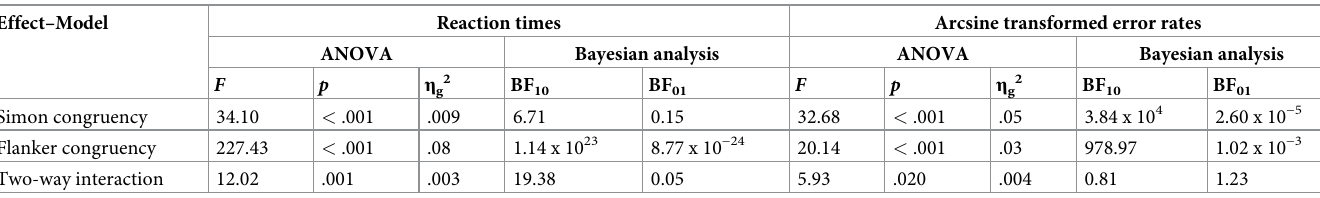
Table 5. Experiment 3: Inferential statistical values for the two-way repeated-measures analysis of variance (ANOVA) with the variables Simon congruency (incon- gruent, congruent) and flanker congruency (incongruent, congruent), and Bayes Factors (BF) from model comparisons.